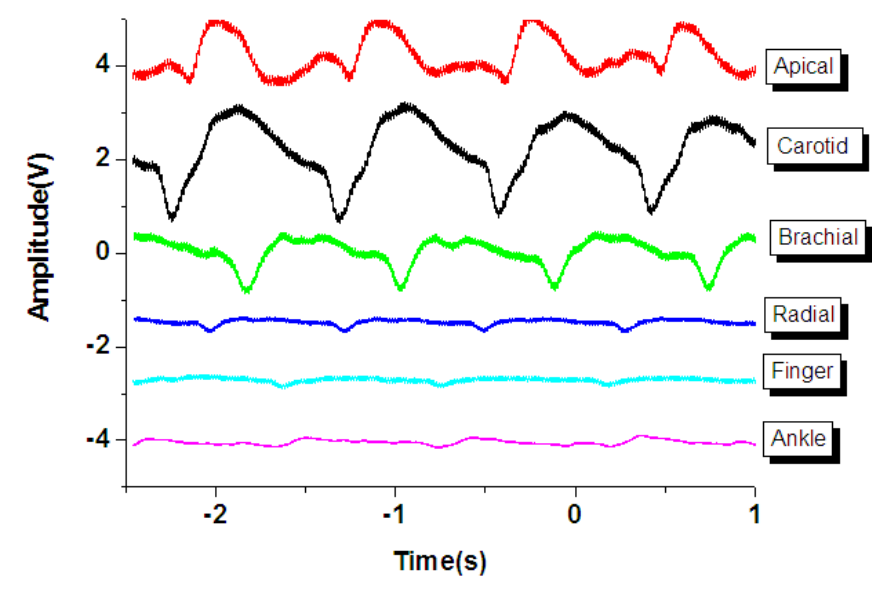
Figure 9. Comparison of pulse amplitude and waveform measured from numerous regions of the human body with our